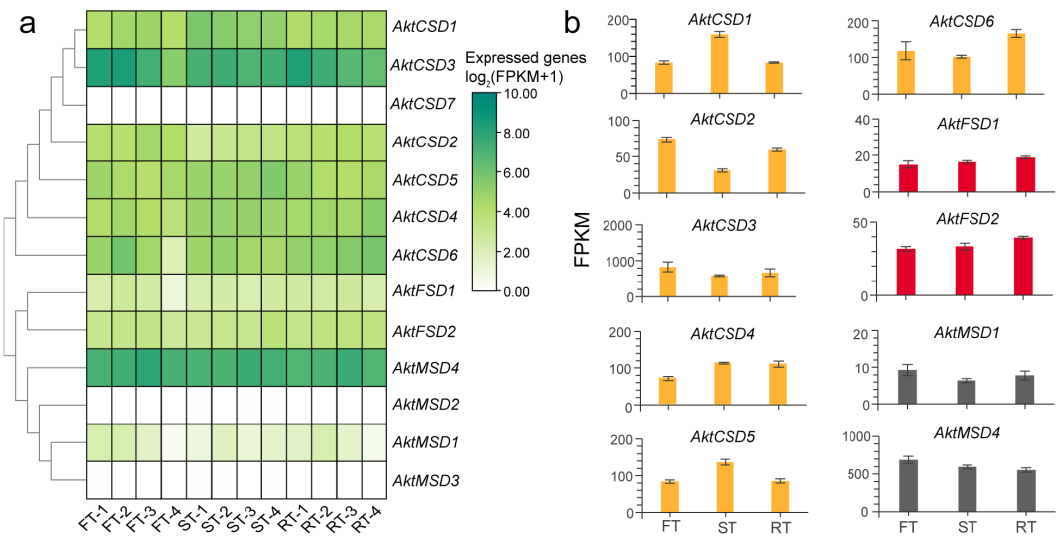
Figure 5. Expression levels of 13 AktSODs in different tissues and developmental stages (FT: flesh, ST: seed, RT: rind, 1: young stage, 2: enlargement stage, 3: coloring stage, 4: mature stage). ( a ) Heatmap of expression of 13 AktSODs in three fruit tissues at four stages. ( b ) Total expression of AktSODs in three fruit tissues contains the total FPKM of each fruit tissue in its four development stages. The error bars of the column represent the standard deviation of FPKM in the four development stages. The different colors of the column represent three subfamilies of AktSODs .